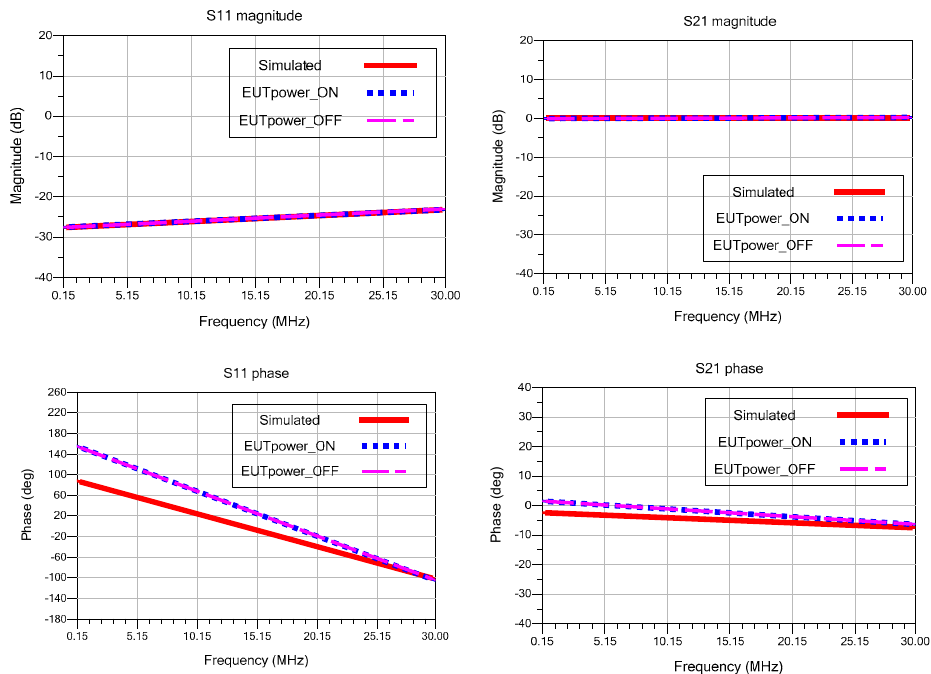
Figure 11. Comparison of the S-parameters obtained by simulations (red), EUT not powered (pink), and EUT powered (blue) for the SEPIC Converter Model MCP1663.